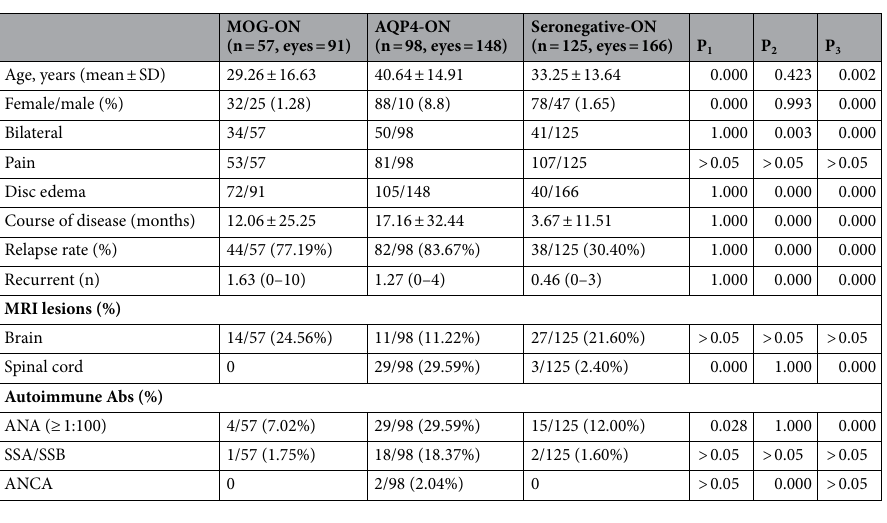
Table 1. Demographic and clinical characteristics of patients in the three groups. MOG, myelin oligodendrocyte glycoprotein; AQP4, aquaporin-4; ON, optic neuritis; Abs, antibodies; ANA, antinuclear antibody; SSA/SSB, Sjögren syndrome A/B; ANCA, anti-neutrophil cytoplasmic antibody; P 1 , P value MOG-ON compared to AQP4-ON; P 2 , P value MOG-ON compared to seronegative-ON; P 3 , P value AQP4-ON compared to